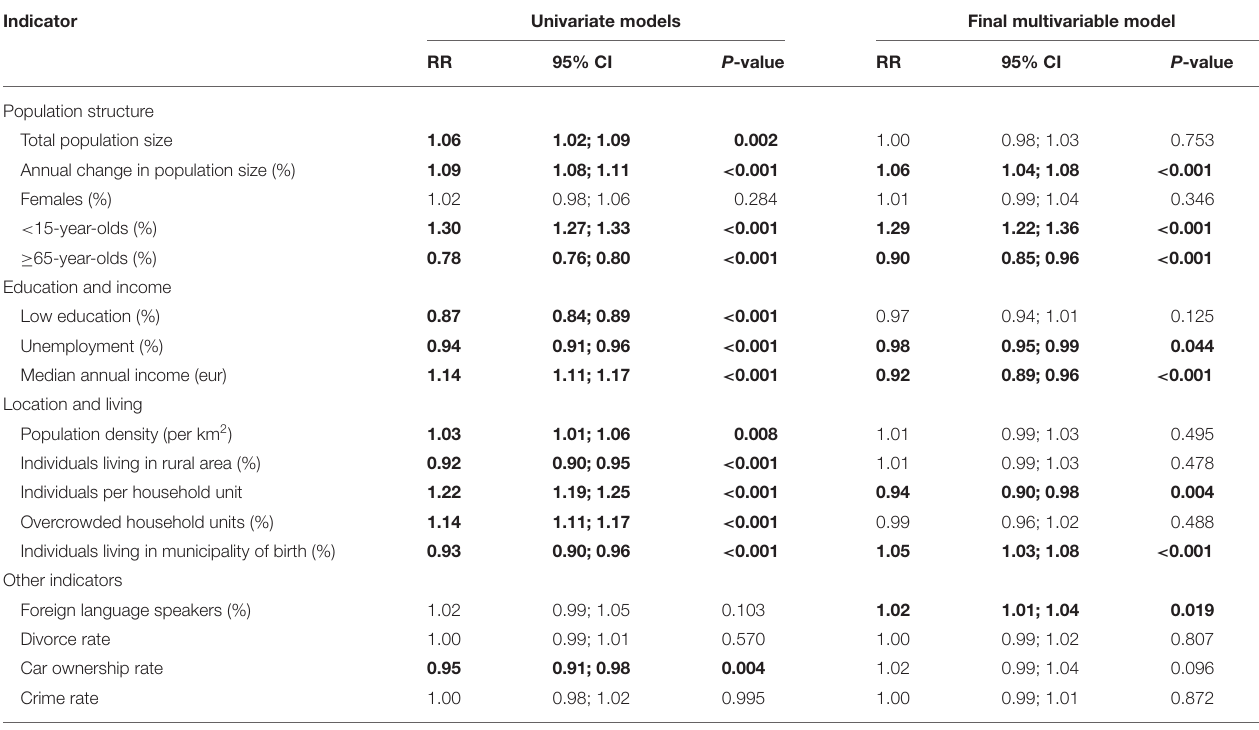
TABLE 2 | Association between sociodemographic indicators and birth rate in Finland in 2011–2018.